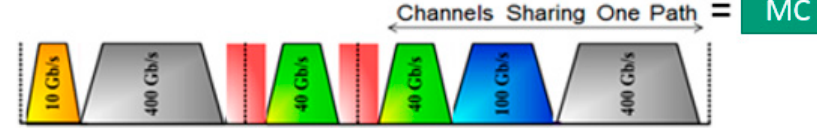
Figure 1. An example of gridless configuration.